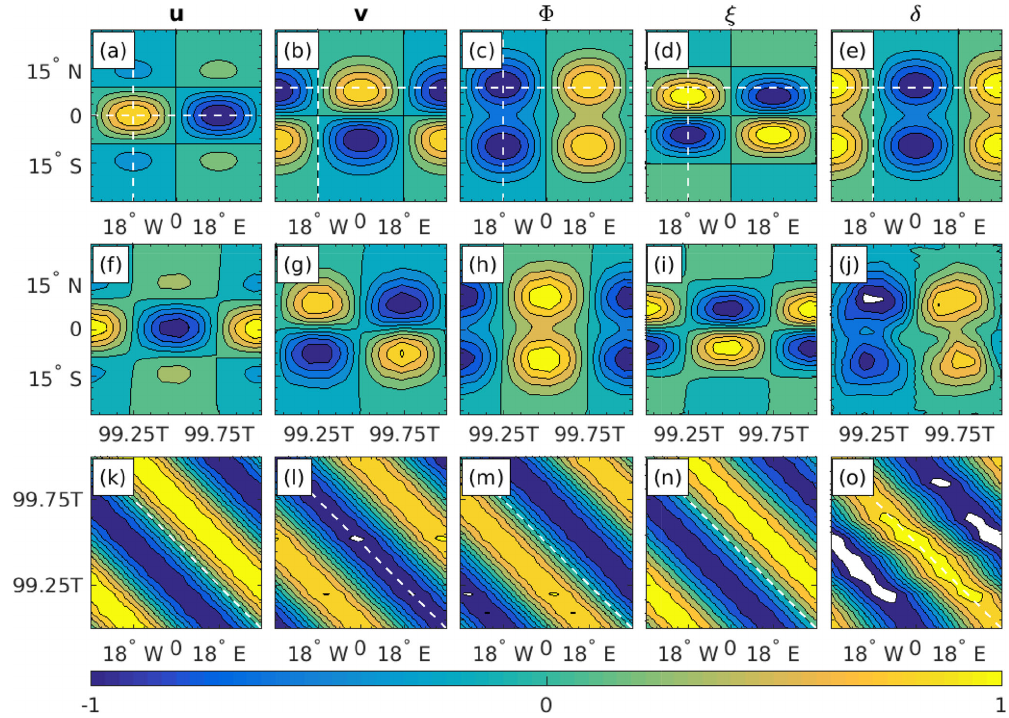
Figure 1. (a–e) The initial u , v , (cid:56) , ξ , and δ Rossby wave fields, obtained using the analytic expressions from Sect. 2 and the wave parameters from Sect. 3.1. (f–j) Latitude–time Hovmöller diagrams of the simulated solutions, obtained by intersecting the fields at λ = − 18 ◦ (also indicated by the white vertical dashed lines in a–e ). (k–o) Time–longitude Hovmöller diagrams of the simulated solutions, obtained by intersecting u at φ = 0 ◦ and all other fields at φ = 9 ◦ (also indicated by the white horizontal dashed lines in a–e ). The simulated solutions were obtained using the equatorial channel finite-difference model. The fields are normalized on their global maximum at t = 0. The wave period for the chosen wave parameters is T = 18 . 5d. Contour levels range from − 1 . 0 to + 1 . 0 in intervals of